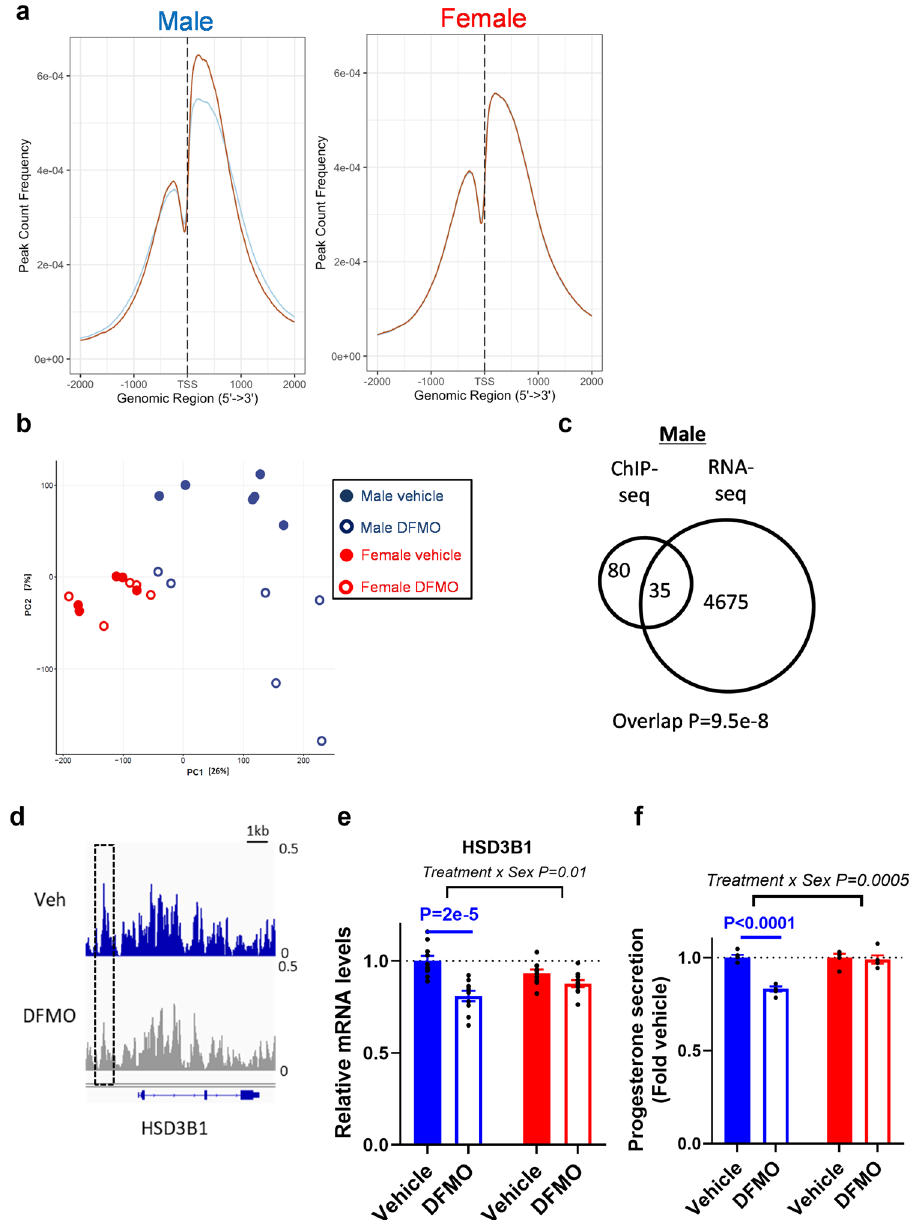
Fig. 6 Polyamine depletion mediates global histone hypoacetylation and progesterone biosynthesis. a H3K27Ac enrichment near transcription start sites is decreased in male PHTs following DFMO treatment. Orange line represents vehicle and blue line represents DFMO treated PHTs. b Unsupervised principal component analysis of H3K27Ac binding to genomic regions in vehicle and DFMO treated male and female PHTs. c Overlap of DBR annotated genes in H3K27Ac ChIP-seq analysis and DEG in RNA-seq analysis. d Custom views of differentially acetylated region in vehicle and DFMO treated male PHTs. Polyamine depletion decreased e HSD3B1 mRNA and f progesterone secretion in male PHTs. ChIP-seq experiments performed in N = 6 male PHTs and N = 5 female PHTs; progesterone secretion measured in N = 5 male PHTs and N = 5 female PHTs. Male and female samples are coloured blue and red